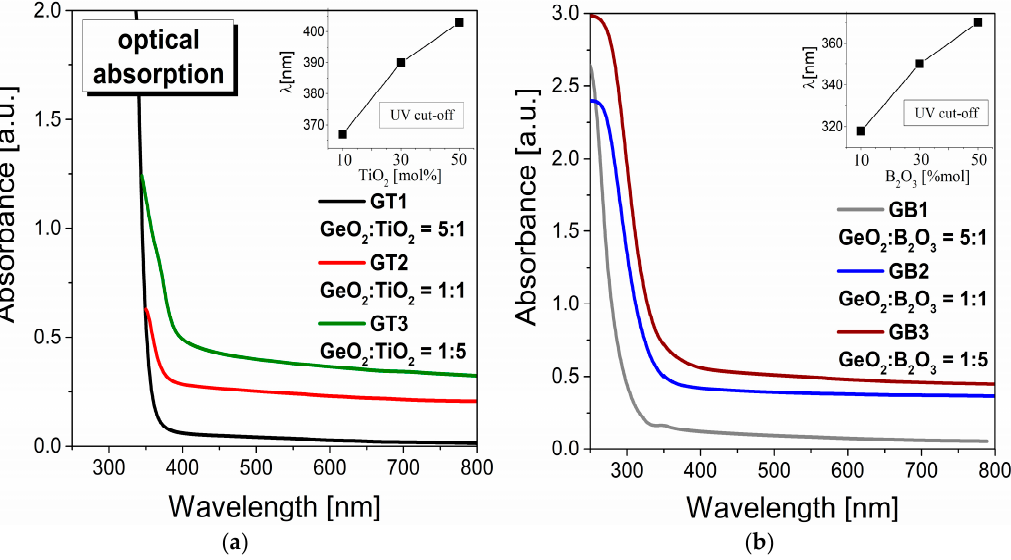
Figure 4. UV–visible optical absorption spectra for glass systems modified by TiO 2 ( a ) and B 2 O 3 ( b ). Insets show the variation in UV cut ‐ off as a function of TiO 2 and B 2 O 3 concentration.